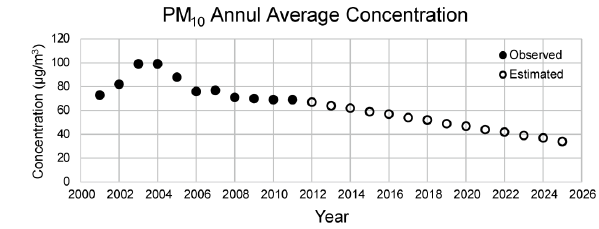
Fig. 12. Long-term PM 10 annual average concentration (µg m -3 ) trend in Guangzhou, 2000-2025.